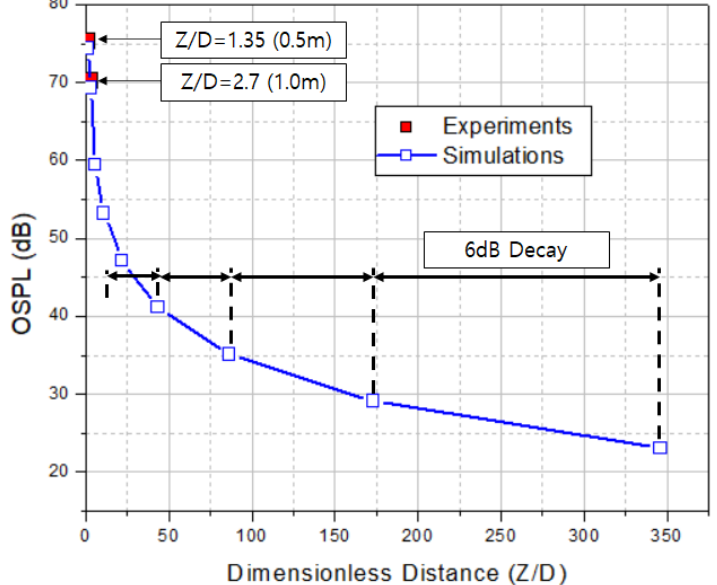
Figure 13. Overall sound pressure level (OPSL) history of the dimensionless distance by the Ffowcs-Williams and Hawkinbygs (FW-H) model at the various receivers with doubling of distance in the downstream region and the comparison with experiments at Z / D = 1.35 and 2.7 corresponding to each location of 0.5 and 1.0 m, respectively.